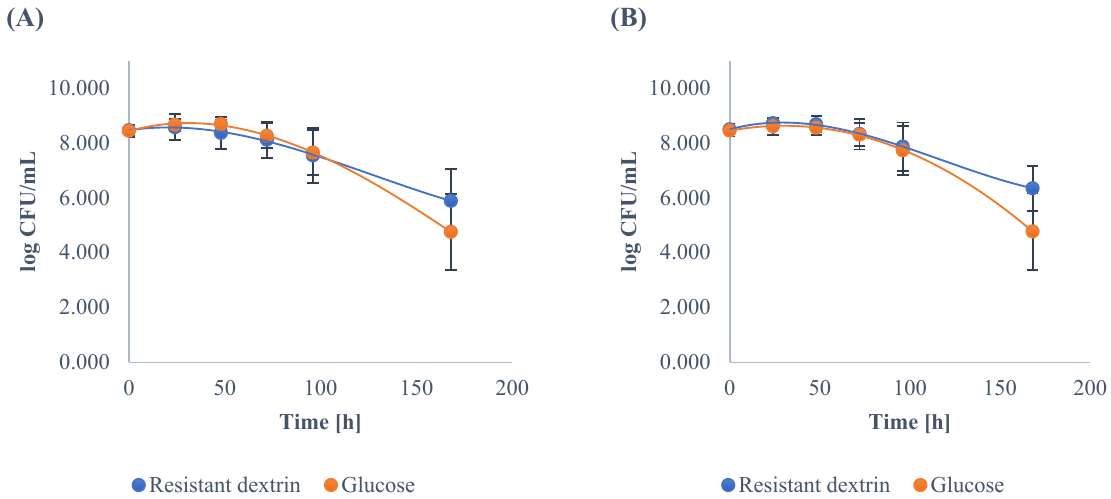
Figure 3. The growth of Clostridium ( A ) and Bacteroides ( B ) in the medium enriched with the resistant dextrin and with glucose as the control. The results show the means and standard deviations.